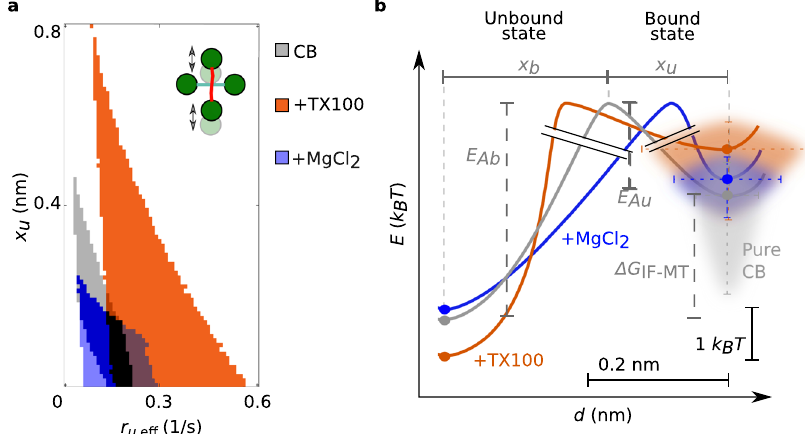
Fig. 4 Hydrophobic and ionic reagents change the IF-microtubule bond properties. a Valid unbinding rates r u ,eff and potential widths x u to simulate the experimental data shown in Fig. 3c, e, and g for the different buffer conditions: pure CB (gray), CB with TX100 (orange), and CB with additional magnesium (blue). r u ,eff and x u pairs, which are valid for several buffer conditions, are color coded by mixed colors. r u ,eff and x u increase from additional magnesium chloride across pure CB to added TX100. b Energy landscape for the theoretical modeling of the IF-microtubule bond: A two-state model (unbound, bound) is suf fi cient to describe the experimental data shown in Fig. 3. From the binding and unbinding rates, we calculated the differences in activation energies E Ab and E Au (see Eq. (8) in the Supplementary Information) of bonds in different buffer conditions to open or close. However, the absolute values cannot be determined, as indicated by the graph break (black double-lines). For different buffer conditions, the position of the energy barrier relative to the unbound and bound state, x b and x u , respectively, changes. Source data are provided as a Source Data fi different sets of r u ,eff and x u and compared the resulting distributions of breaking forces to our experimental data. We accepted the tested parameter sets if the distributions passed the Kolmogorov-Smirnov test with a signi fi cance level of 5%. The